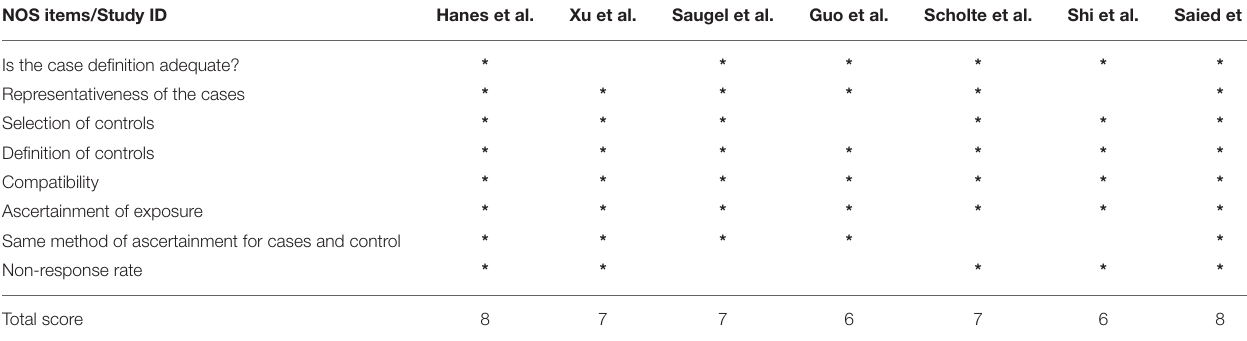
TABLE 2 | Risk of bias assessment of the included studies according to the Newcastle-Ottawa Scale (NOS). NOS items/Study